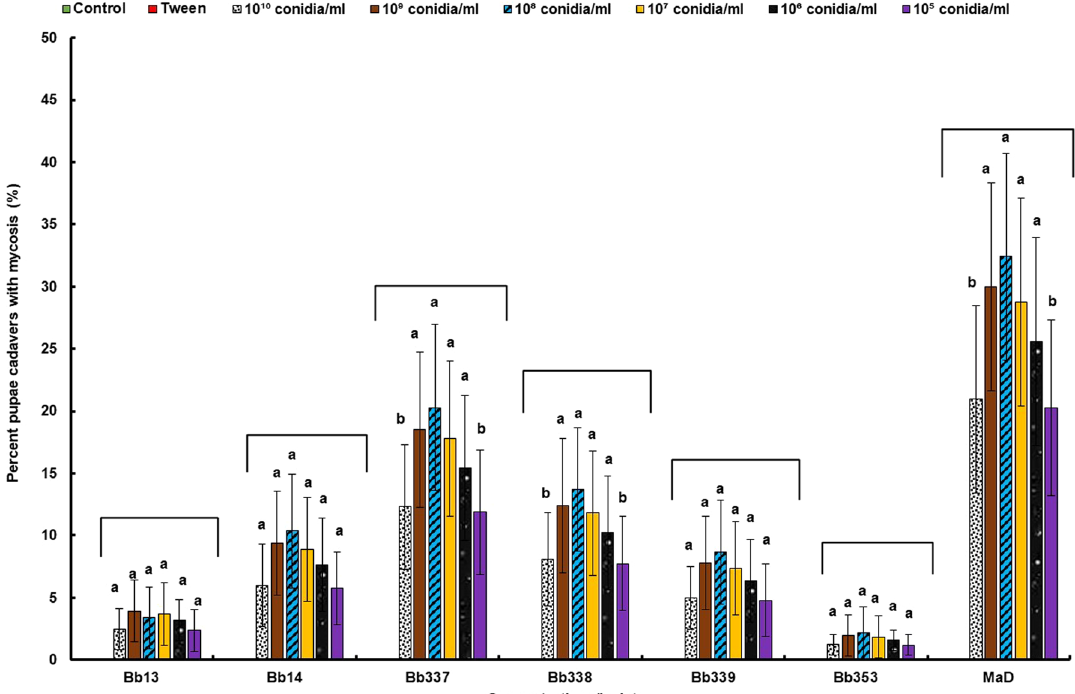
Fig. 7 Cadavers Zeugodacus cucurbitae pupae with fungal growth after treatment with different concentrations of isolates of Beauveria bassiana and Metarhizium anisopliae in pupal inoculation method